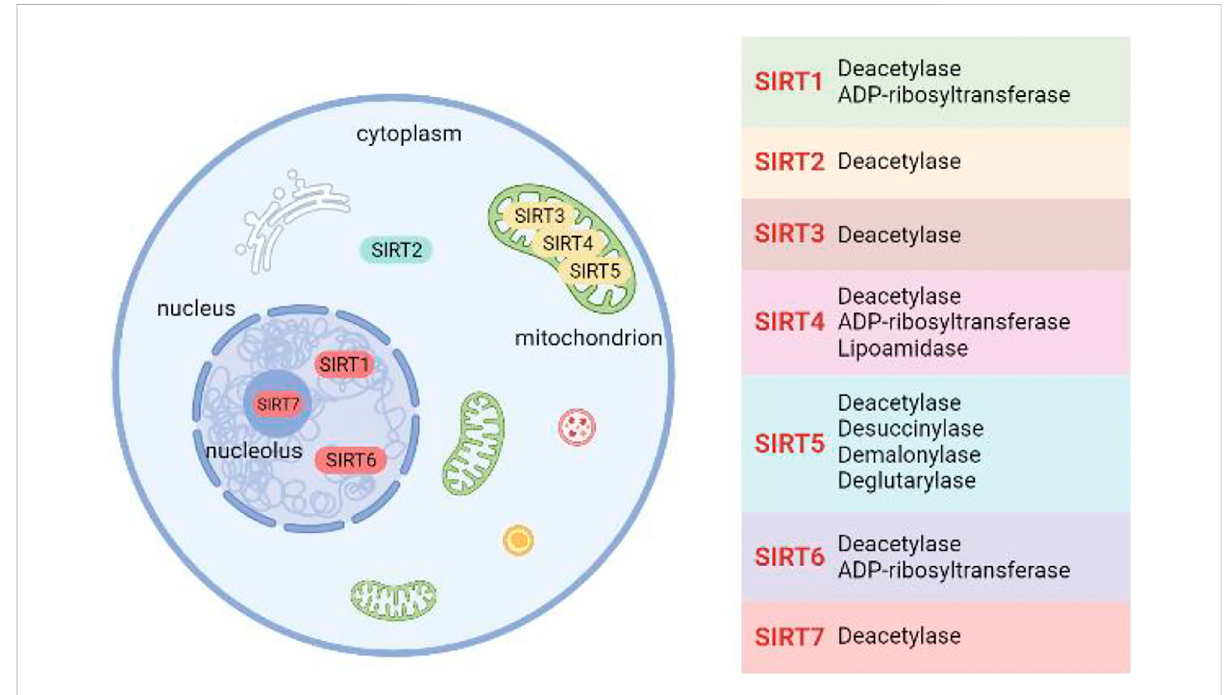
FIGURE 1 The role of sirtuins in kidney